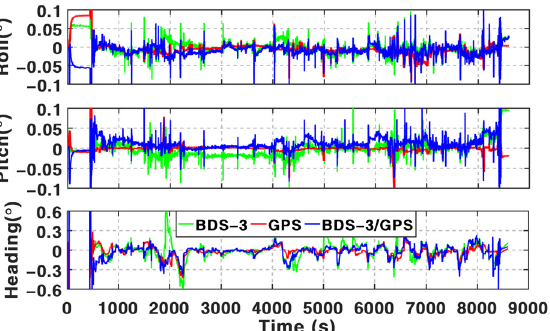
Figure 19. Attitude differences between BSSD PPP/INS TCI and BSSD PPP/INS/ODO with different